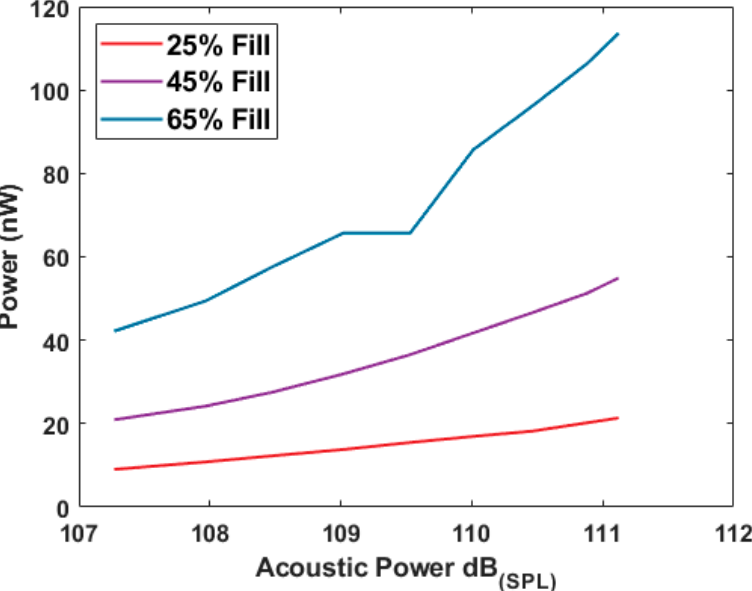
Figure 4. Peak power generation for the samples with different fill factors as a function of sound pressure (dB SPL ).